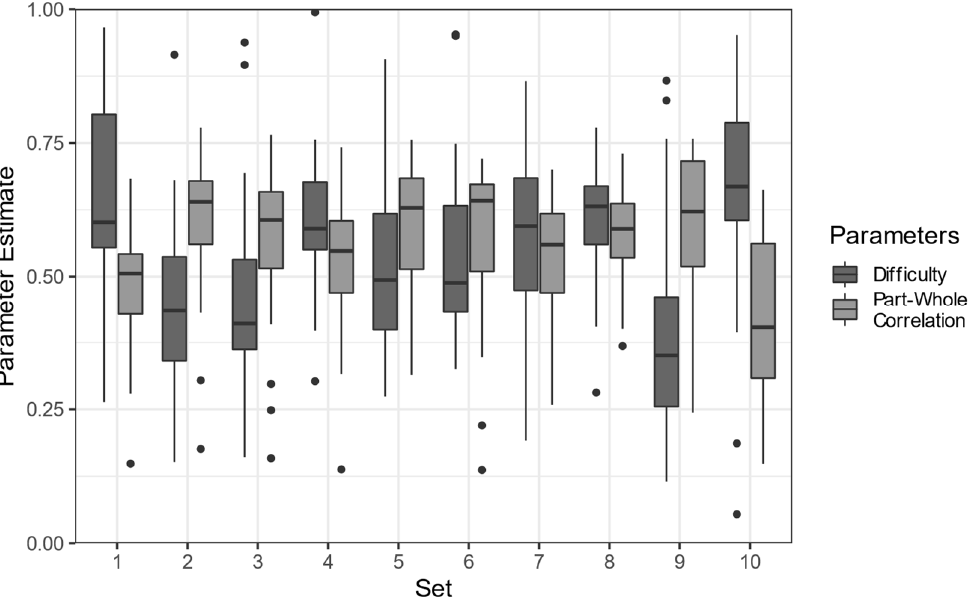
Figure 2. Item difficulties and part–whole correlations as estimated by classical test theory. Black dots represent outliers.